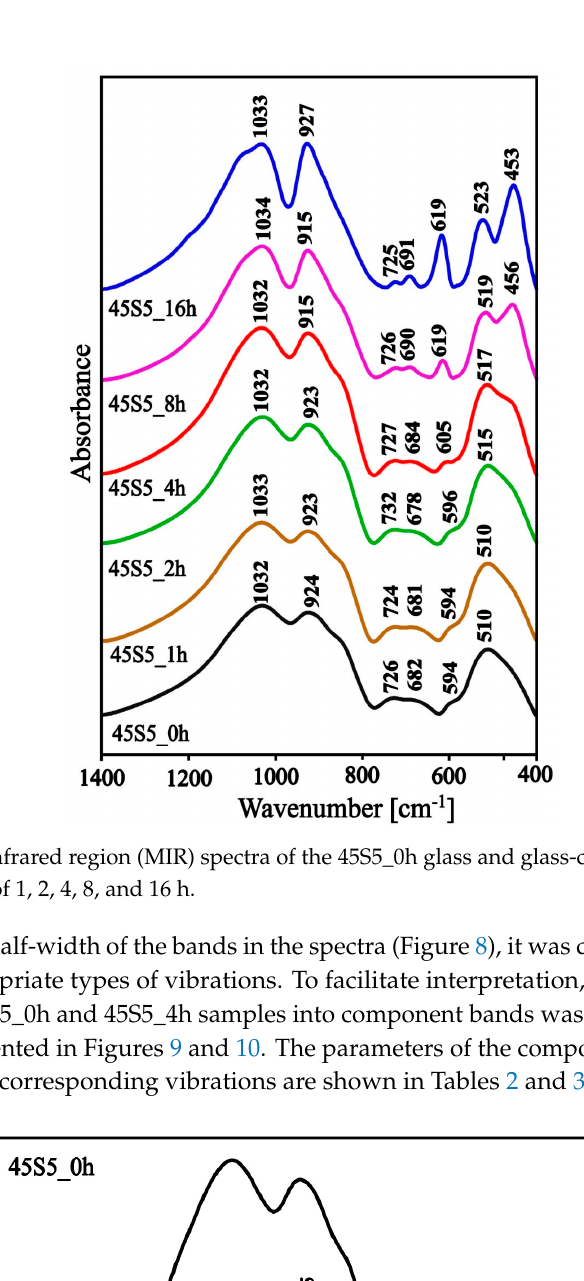
Figure 9. Deconvoluted MIR spectrum of the 45S5_0h sample.